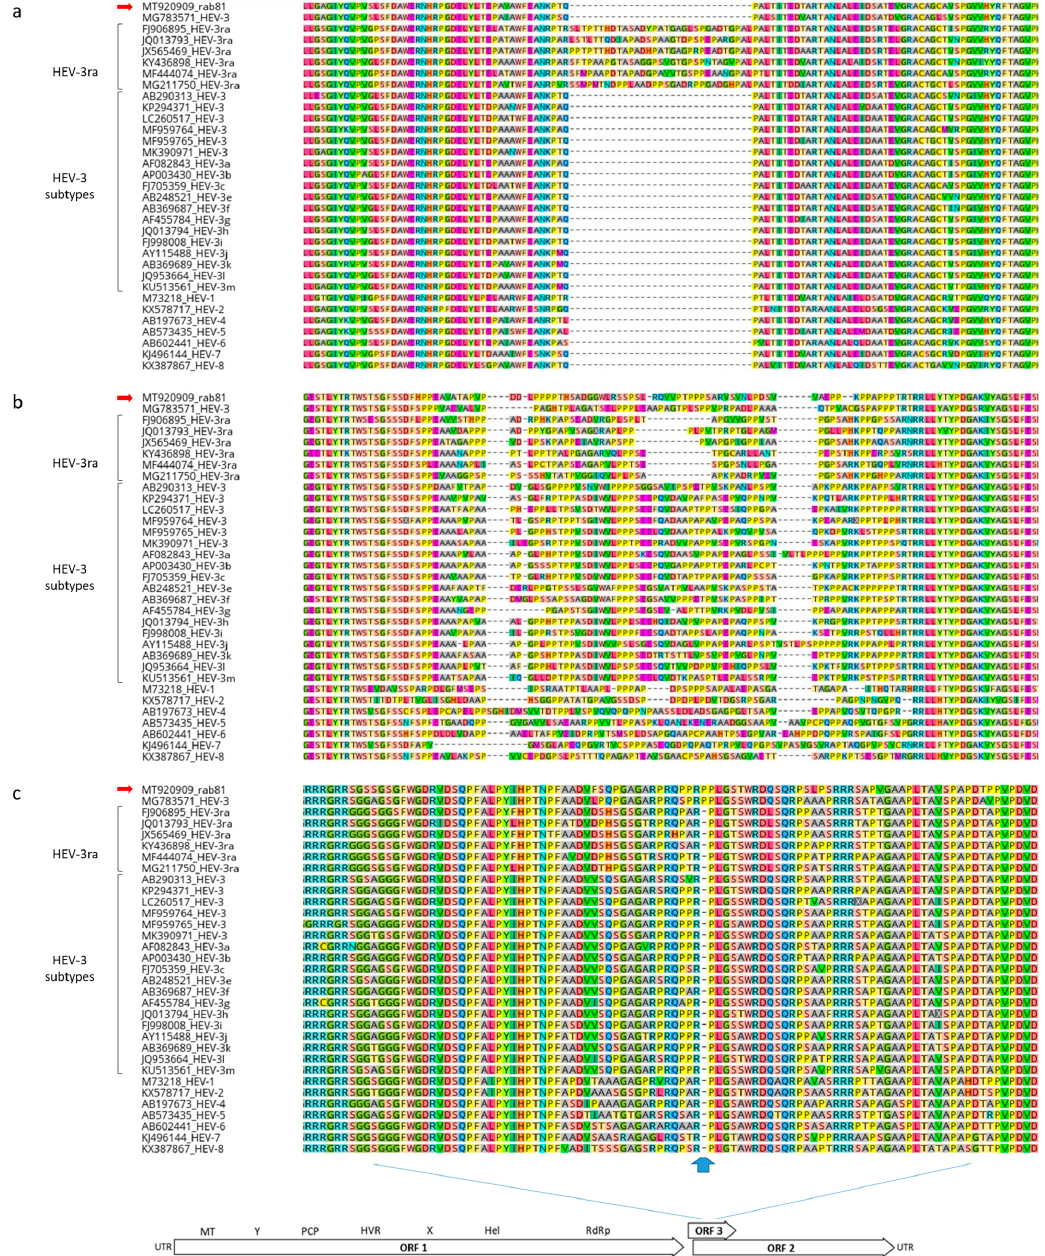
Figure 5. Amino acid sequence alignments of X-region ( a ) and hypervariable region of ORF1-encoded polyprotein ( b ), and capsid protein encoded by ORF2 within the ORF2/ORF3 overlap region ( c ). The X-region of ORF1 refers to nucleotide positions 2776–2932 of MT920909 (strain rab81). The hypervariable region is flanked by conserved TRTWS and RRLL amino acid sequences (refers to nucleotide positions 2146–2379 of MT920909, strain rab81). The position of the proline insertion within the ORF2-encoded capsid protein amino acid sequence refers to nucleotide positions 5408–5410.